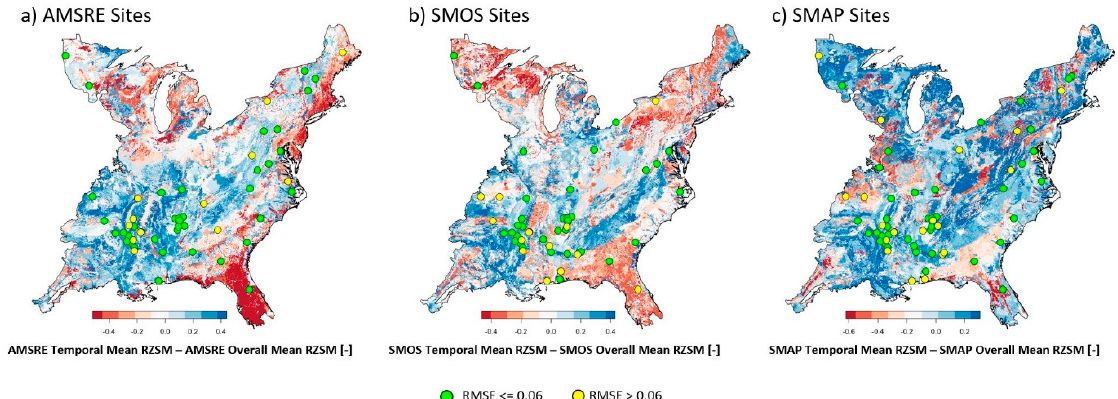
Figure 7. Maps of the difference between the temporal mean of RZSM predictions from the regional SMAR model and the overall mean of these predictions made using ( a ) AMSRE, ( b ) SMOS, and ( c ) SMAP satellite data as inputs into SMAR. Points indicate SCAN/AMERIFLUX training sites that are colored according to whether they exceed a quality benchmark of RMSE = 0.06 cm 3 cm − 3 or not. The RMSE is based upon predictions associated with each satellite platform individually.